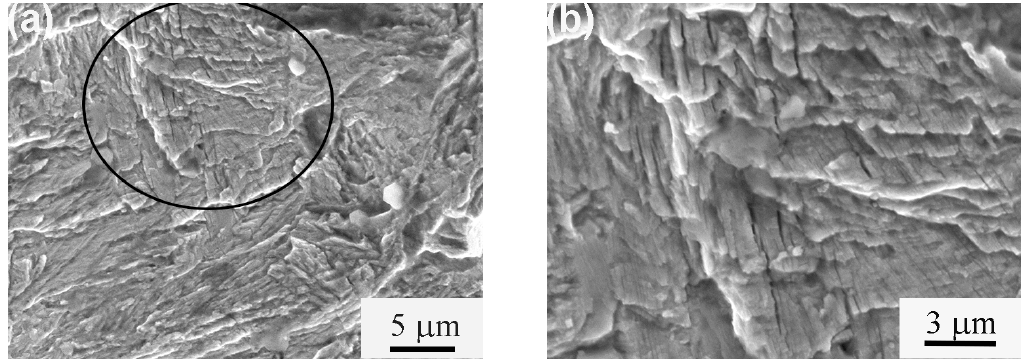
Figure 5. SEM fatigue fracture surface morphologies of isothermally-transformed samples. ( a ) A3 sample (1.4 GPa, 84,385 cycles), fracture initiate from MnS inclusion in sample interior; ( b ) A3 sample